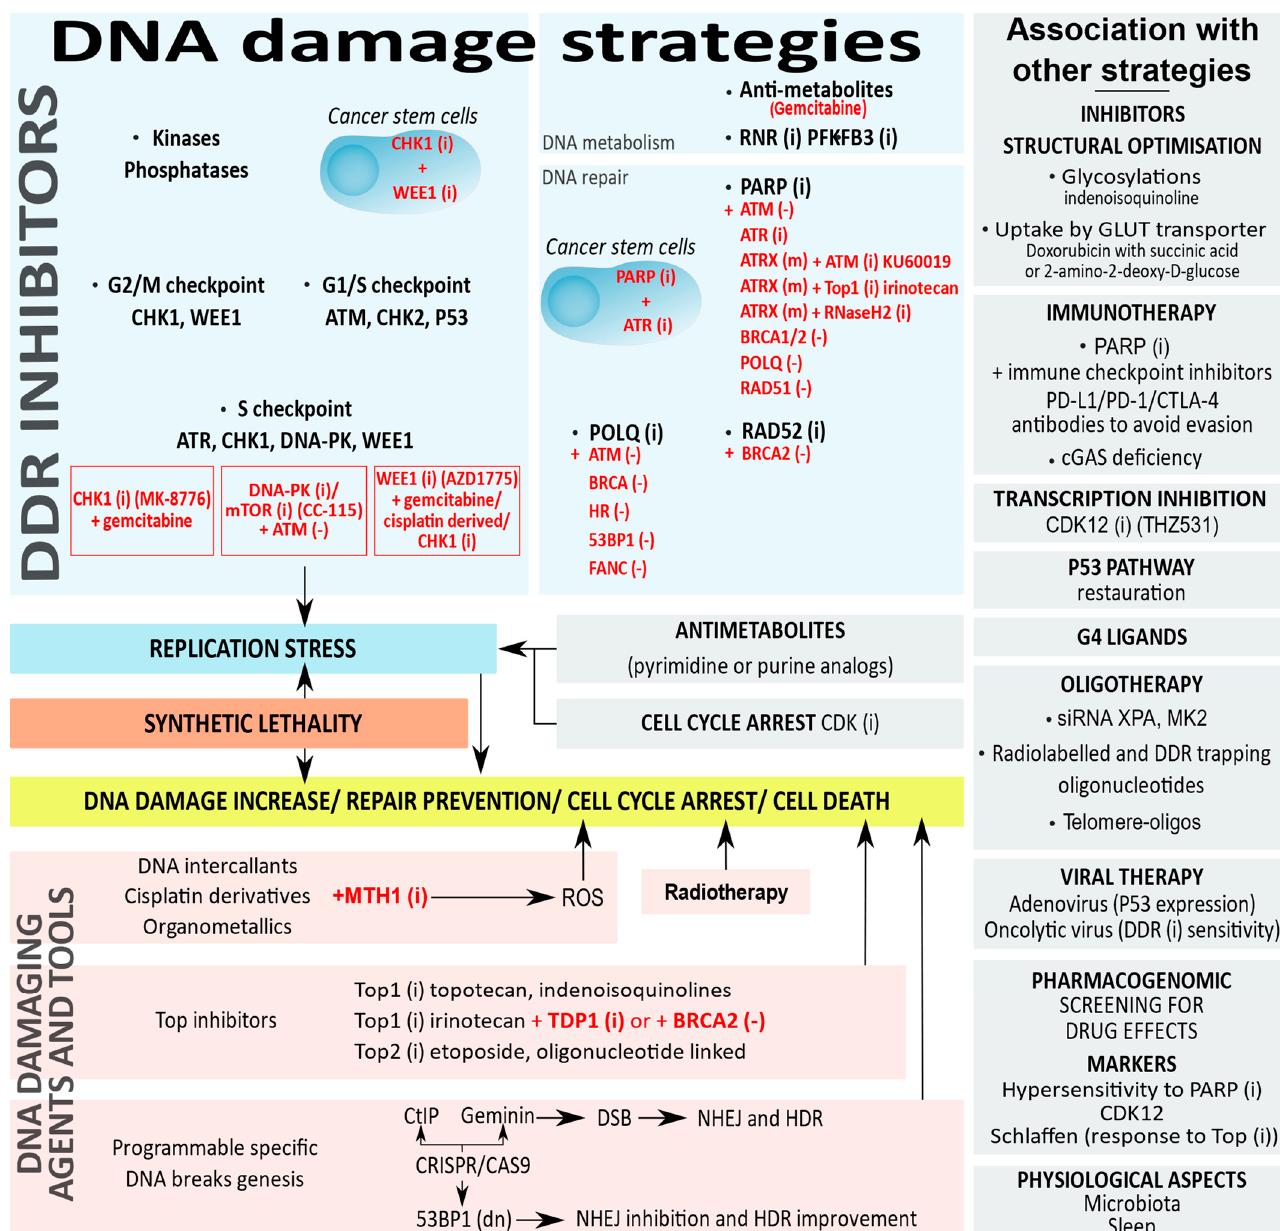
Figure 4. DNA damage strategies in cancer chemotherapies and possible combined therapies. Synthetic lethality is in red. Deficiency (-), dominant negative (dn), inhibitors (i), mutations (m).